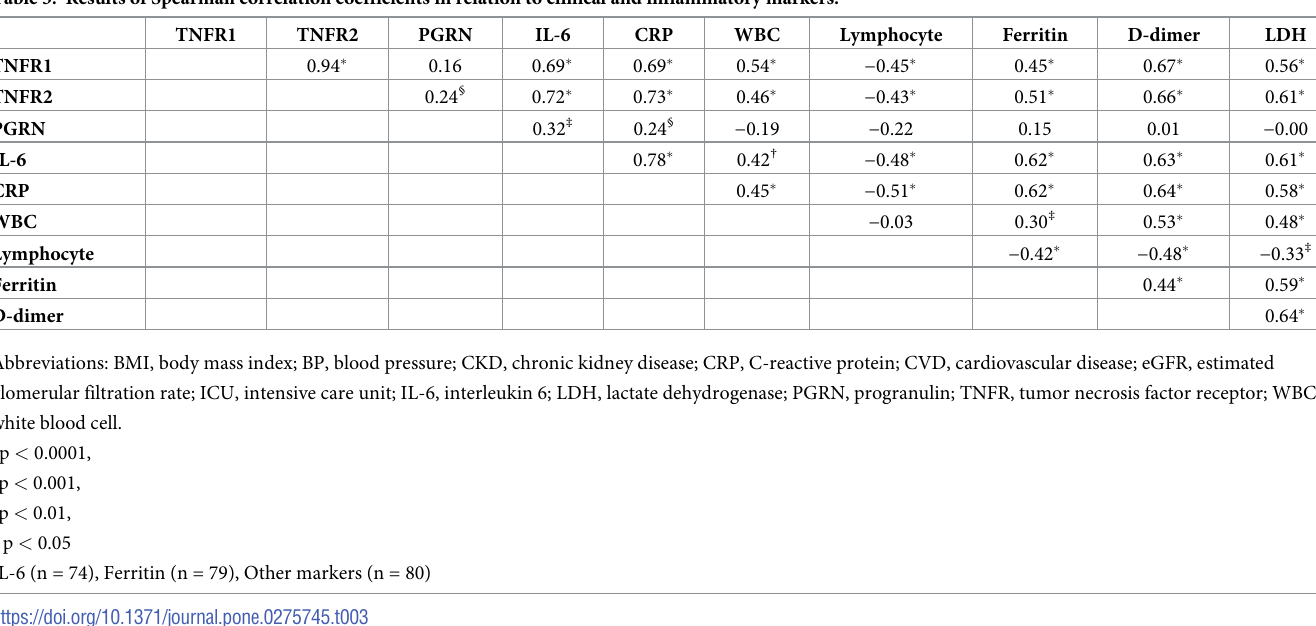
Table 3. Results of Spearman correlation coefficients in relation to clinical and inflammatory